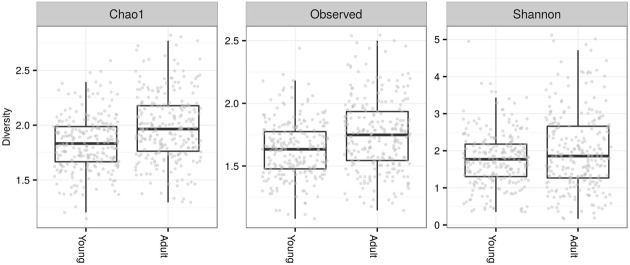
Alpha diversity of FM in juveniles vs. adults. Number of observed operational taxonomic units (OTUs) and Chao1 estimates were log10 scaled, whereas Shannon diversities were not transformed.